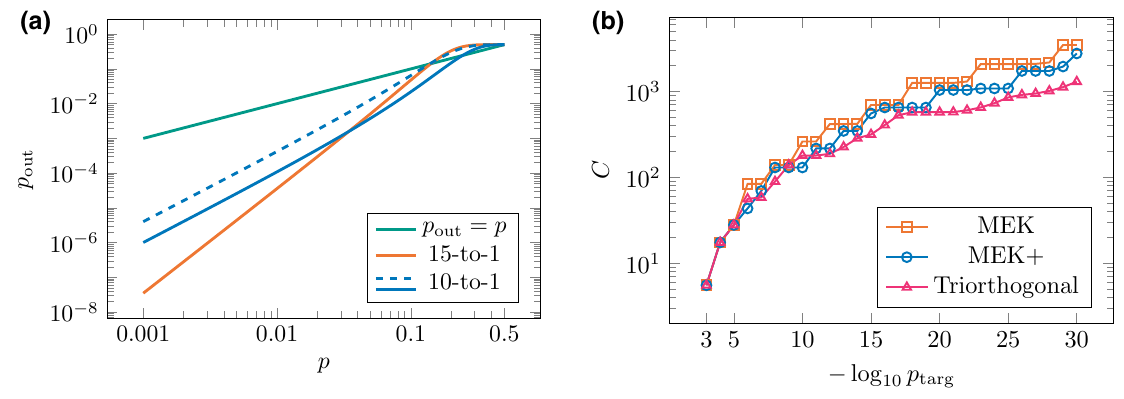
FIG. 3. (a) A plot showing the output error p out as a function of the input error p for the 15-to-1 and 10-to-1 MSD protocols. The solid and dashed blue lines correspond to optimistic [Eq. (4)] and pessimistic [42] noise models for the | CCZ (cid:5) state, respectively. (b) A plot showing the distillation cost C for different target error rates p targ , assuming an input error rate of p = 0.01 and the optimistic noise model for | CCZ (cid:5) states. The cost for our MEK+ protocol (blue) is always smaller than the MEK protocol cost (orange) and even beats the triorthogonal protocol cost (magenta) for some values of p targ